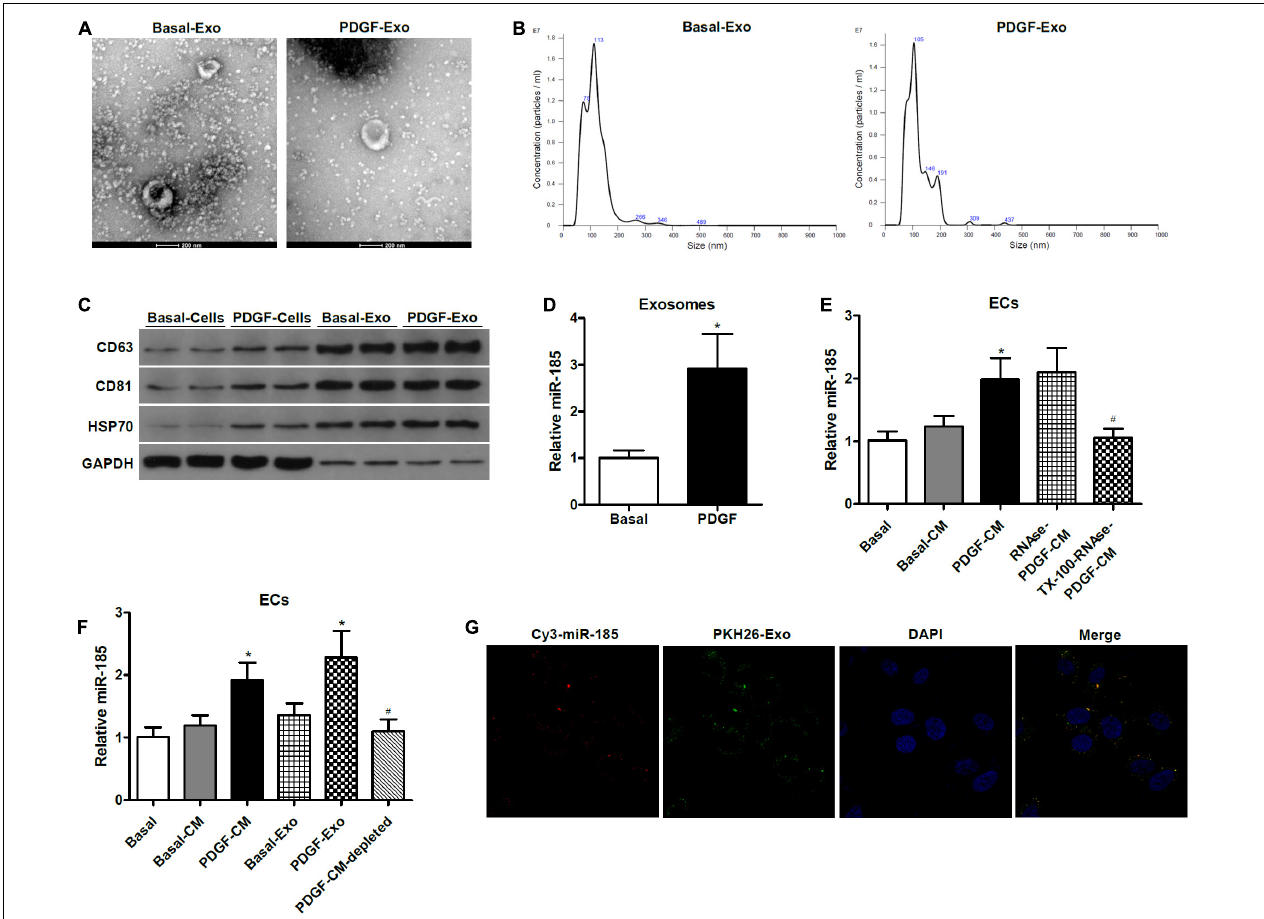
FIGURE 2 | miR-185 was transferred from PDGF-stimulated VSMCs to ECs via exosomes. (A) Representative electron microscopy image of isolated exosomes from the supernatant of VSMCs under both basal (Basal-Exo) and PDGF conditions (PDGF-Exo). (B) Representative NTA histogram of isolated exosomes from the supernatant of VSMCs under both basal (Basal-Exo) and PDGF conditions (PDGF-Exo). (C) Western blot analysis of exosome proteins. (D) qRT-PCR detection of miR-185 expression in exosomes derived from VSMCs in basal condition and from VSMCs exposed to 20 ng/mL PDGF for 24 h. * P < 0.05. (E) Levels of miR-185 in ECs incubated with CM from VSMCs in basal conditions and from VSMCs exposed to 20 ng/mL PDGF were treated with or without RNase I and/or Triton X-100. * P < 0.05 vs. Basal-CM, # P < 0.05 vs. RNAse-PDGF-CM. (F) Levels of miR-185 in ECs exposed to different media or exosomes derived from VSMCs following different treatment. * P < 0.05 vs. Basal-CM or Basal-Exo, # P < 0.05 vs. PDGF-Exo. (G) Internalization of PKH67-labeled exosomes derived from VSMCs transfected with Cy3-miR-185.